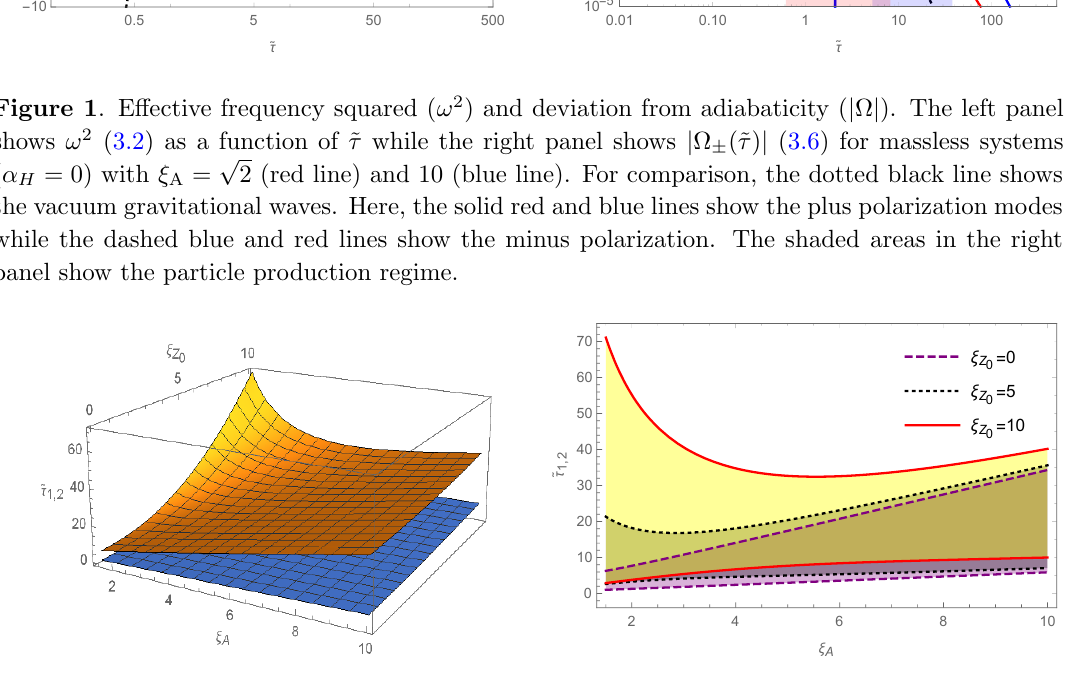
Figure 2 . (left) ~ (cid:28) 1 ; 2 interval for which B (cid:27) has instability as a function of (cid:24) A and (cid:24) Z slices of the left panel. We show ~ (cid:28) 1 ; 2 as a function of (cid:24) A for (cid:24) Z (dotted) black, and (cid:24) Z